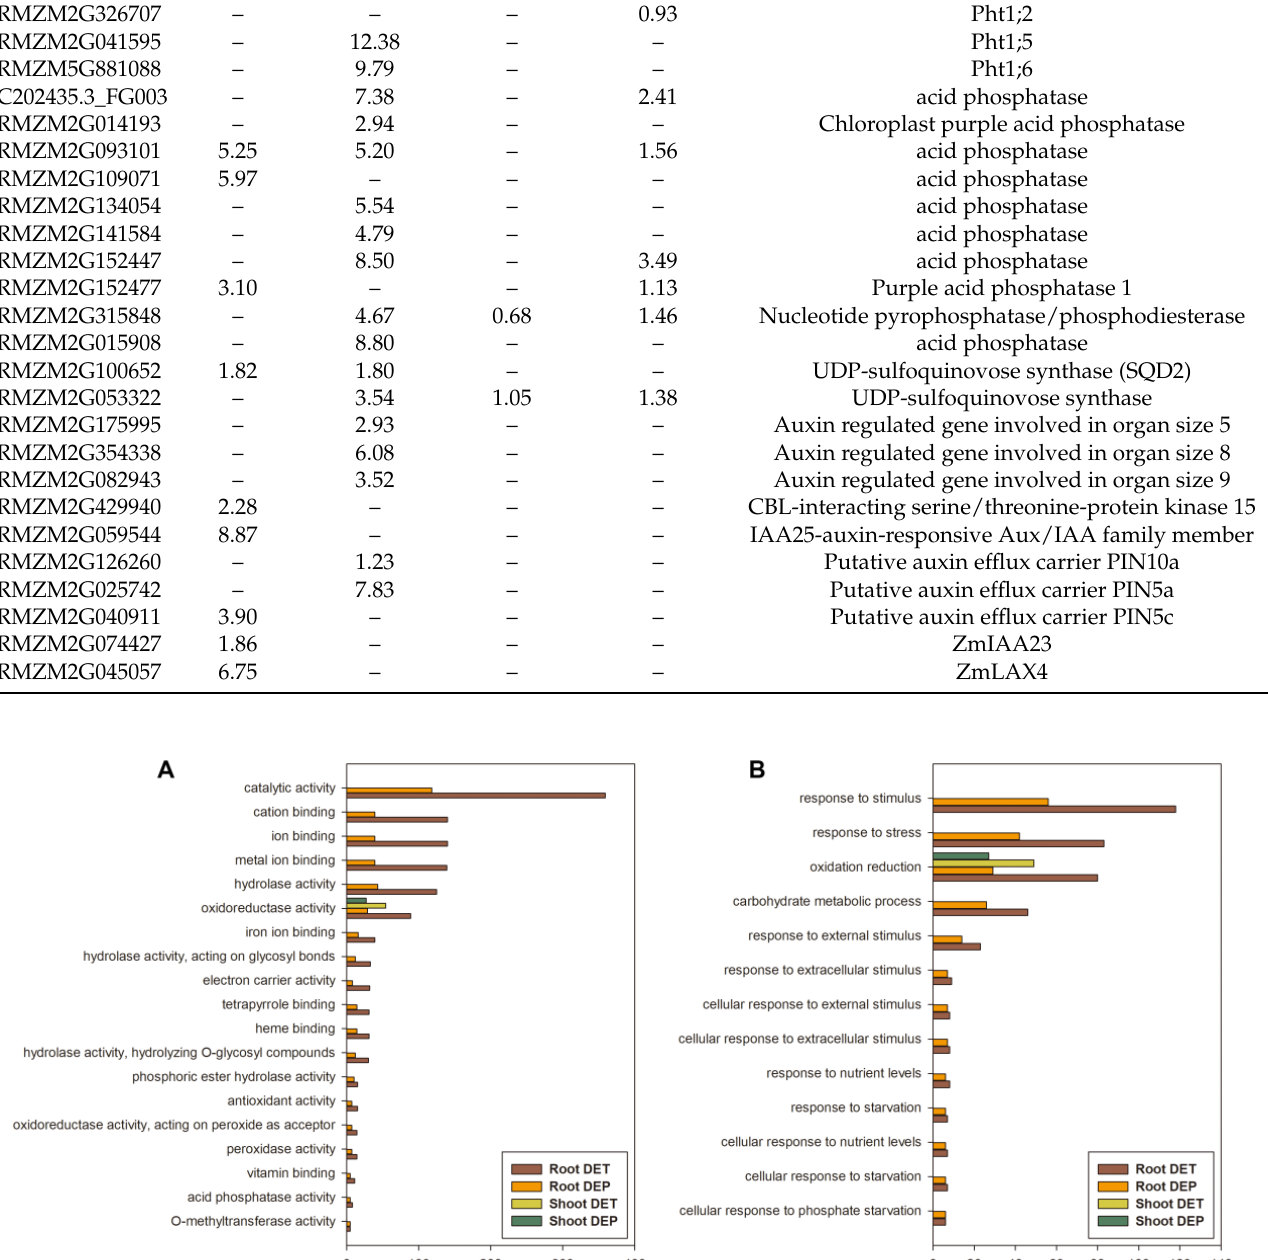
Figure 4. Protein interactions of differentially expressed genes in shoot and root. Among these DEGs, SQD (GRMZM2G053322) sharply increased. Under low-Pi, the translocation of sugar leads to changes in the root to shoot ratio and SQD plays an im- portant role in this metabolic process. Moreover, it was found that this enzyme is located in the center of the protein–protein interaction of carbon homeostasis under Pi deficiency in maize (Figure 4). Five other genes also showed up-regulated expression at both the transcript and protein levels in this network (Table S2, Figure 4), among which the multi- functional protein gene GRMZM2G117357 can interact with 16 other DEGs (Figure 4), in- cluding a subset of genes that are involved in the oxidation process, indicating that oxi- dation is changed to adapt to low-Pi conditions. Transcription factors (TFs) play a pivotal role in the regulatory mechanisms of plants and in the present study, 145 TFs showed differential expression at the transcript or pro- tein level (Table S4). This included MYB, WRKY, ARF and bHLH, which particularly showed changes at the transcript level. These TFs may play a role in the response to Pi